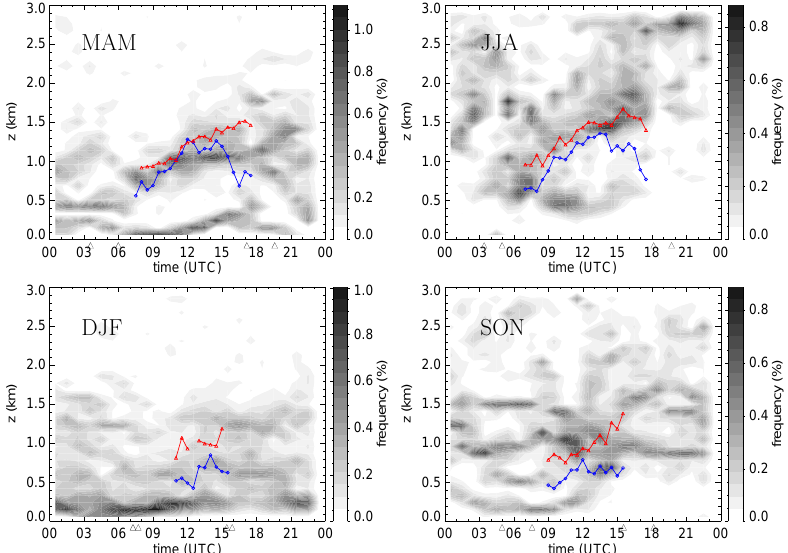
Figure 11. Frequency of occurrence of cloud bases (shading) and overlaid ML from ceilometer (red) and wind lidar (blue) with cloudy cases excluded. Bin size is 90m × 1h. Cloud base heights are excluded from half hour intervals when cloud coverage was larger than 4 octa. Table 3. Seasonal medians of daily maximum MLH (max), time of maximum (h max ) and growth rate (GR) of MLH for JOYCE, December 2011–November 2012.